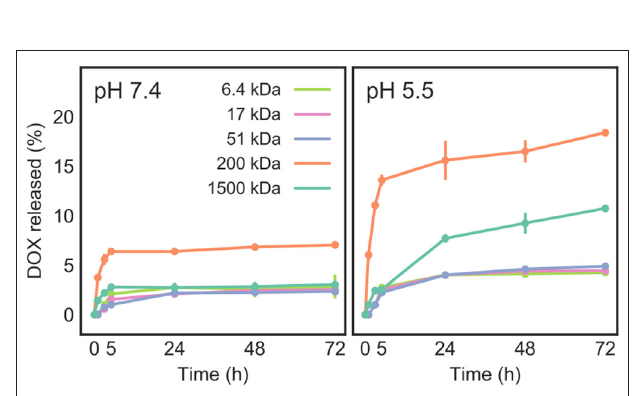
FIGURE 8 | Release of DOX from DOX/CNT/HA-DMPE at pH 7.4 and 5.5, as measured at 37 ◦ C over a 72h